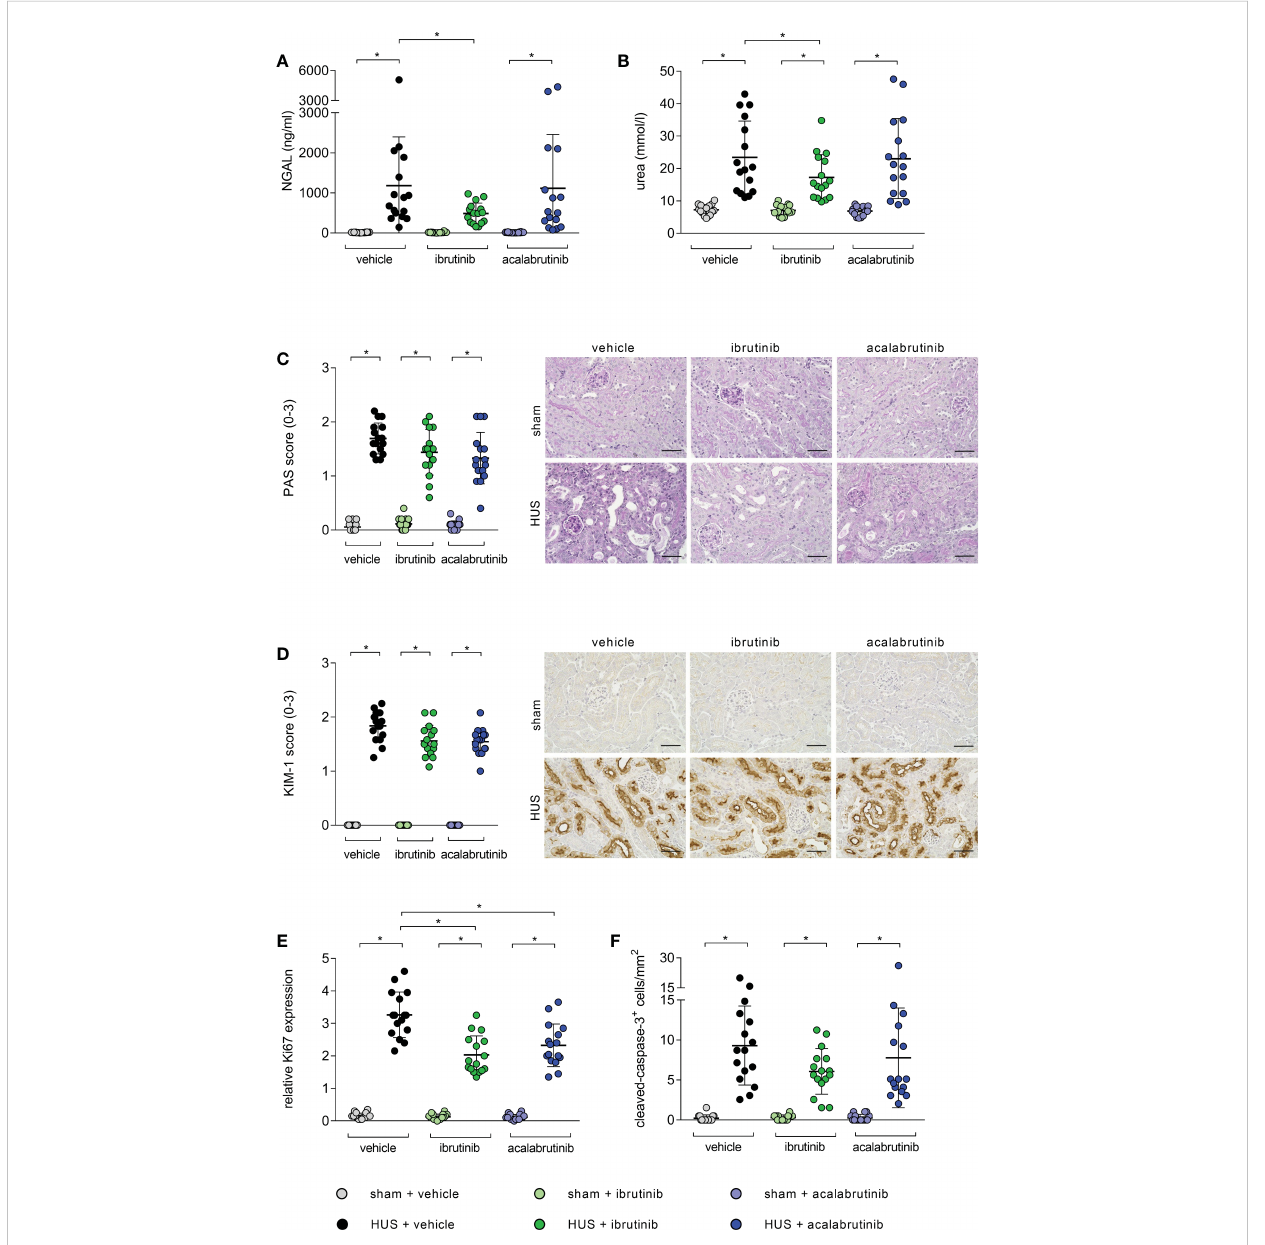
FIGURE 2 Parameters of kidney injury, proliferation and apoptosis of mice with HUS treated with ibrutinib or acalabrutinib. Determination of plasma (A) NGAL and (B) urea (n = 16 per group) on humane endpoint or day 7. Quanti fi cation and representative images of (C) PAS reaction and (D) relative KIM-1 expression in renal sections (n = 16 per group) on humane endpoint or day 7. Bars = 50 µm (400x magni fi cation). Quanti fi cation of renal (E) Ki67 and (F) CC-3 expression (n = 16 per group) on humane endpoint or day 7. Data are expressed as scatter dot plot with mean + SD. (A, B, E) ordinary one-way ANOVA + Holm-Sidak ’ s multiple comparison test, (C, D, F) Kruskal-Wallis test + Dunn ’ s multiple comparison test. *P < 0.05. NGAL, neutrophil gelatinase-associated lipocalin; PAS, periodic acid Schiff; KIM-1, kidney injury molecule-1; HUS, hemolytic-uremic